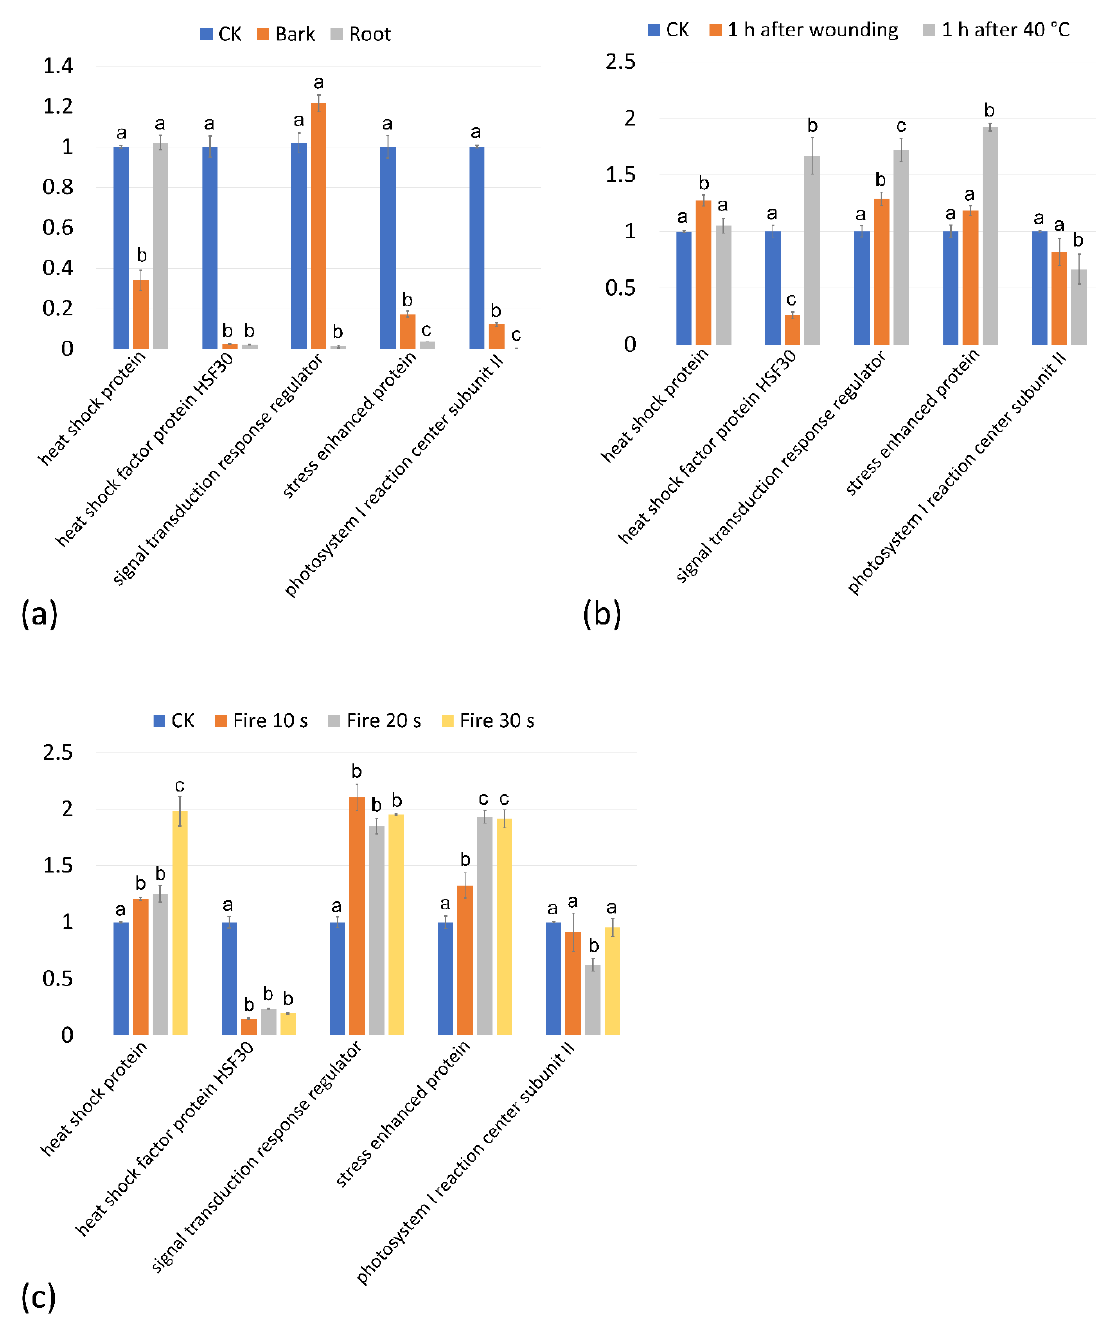
Figure 9. qRT-PCR of five DEGs in organs, wounding stimulation and various heat treatments in Michelia macclurei . The x-axis has the gene names of heat shock protein (Cluster-21881.35845), heat shock factor protein HSF30 (Cluster-21881.45799), stress enhanced protein 2 (Cluster-21881.39835), signal transduction response regulator (Cluster-21881.26260), and photosystem I reaction center subunit II (Cluster-21881.41436). The y-axis shows the relative quantitative expression level by qRT-PCR for each unigene. ( a ) Tissue specificity of DEGs; ( b ) gene expression of 1 h after wounding and conventional heat stress; ( c ) gene expression dynamics of 10 s, 20 s and 30 s, respectively. CK is the normal